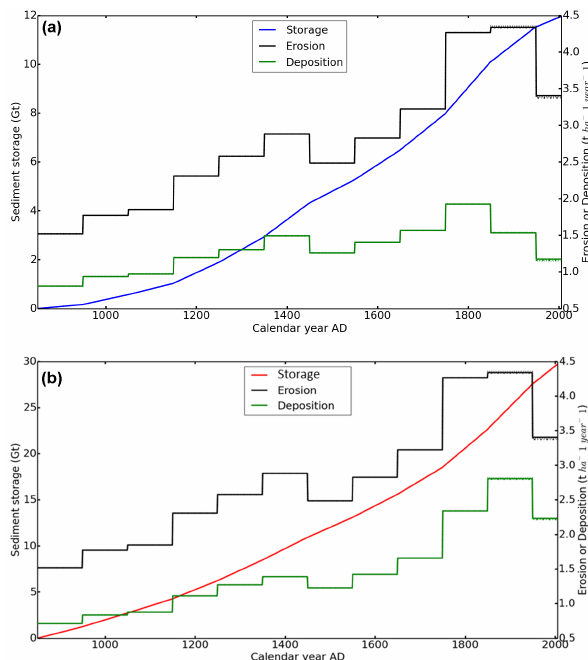
Figure 6. (a) Time series of simulated average erosion (black line), average deposition (green line) and the total change in sediment storage (blue line) with respect to AD850–950 for floodplains in the last millennium in the Rhine catchment. (b) Time series of sim- ulated average erosion (black line), average deposition (green line) and the total change in sediment storage (blue line) with respect to AD850–950 for hillslopes in the last millennium in the Rhine